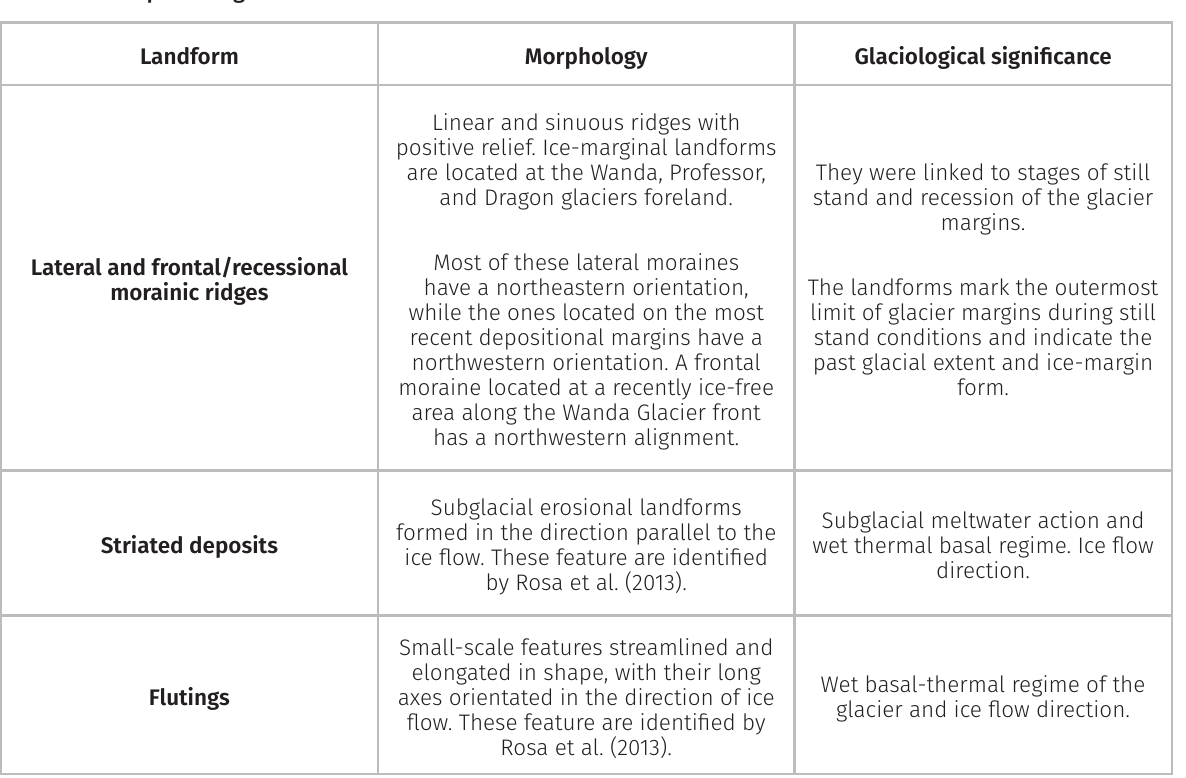
Table V. Description of glacial relief features found in the ice-free sub-aerial sector of